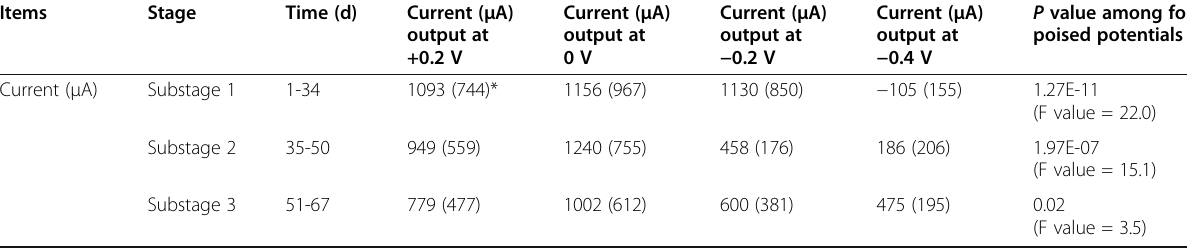
Table 2 Profiles of average current production at four poised potentials